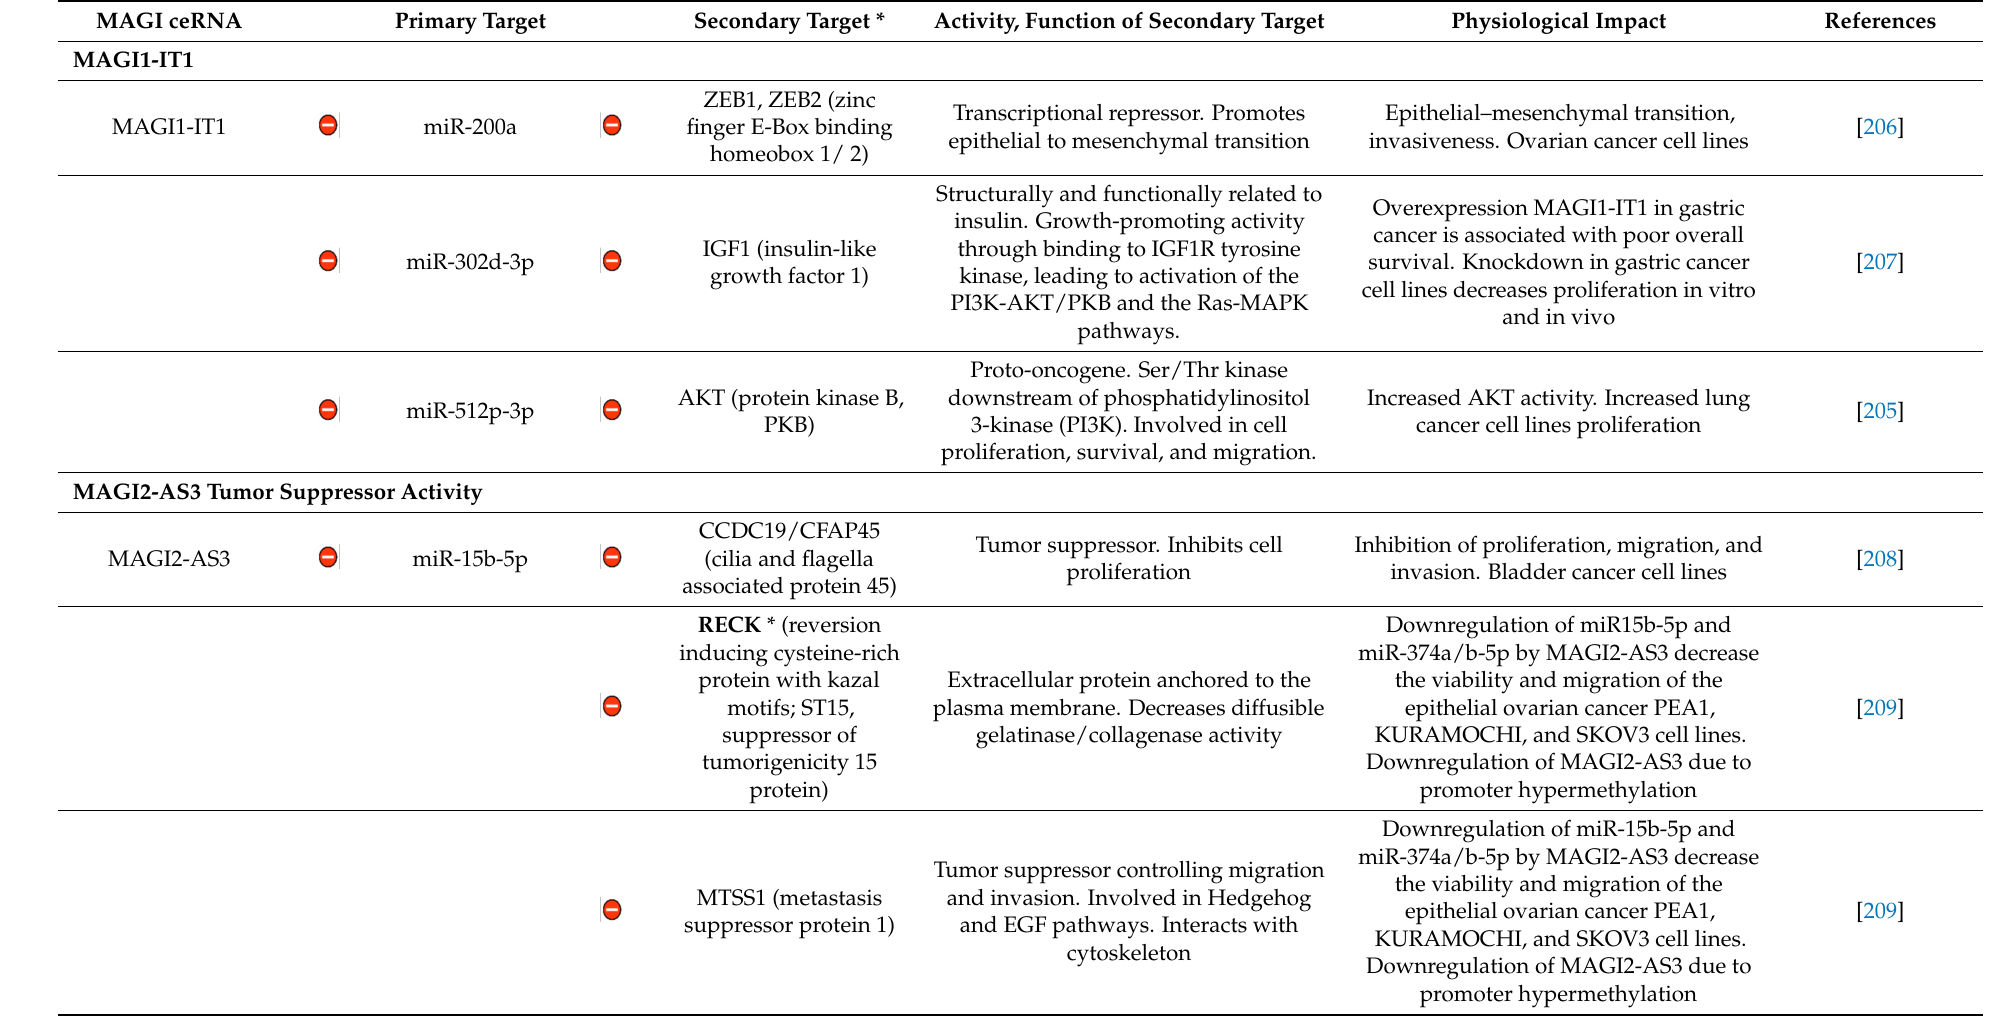
Table 4. Molecular targets of MAGI ceRNAs and effectors systems. Physiopathological